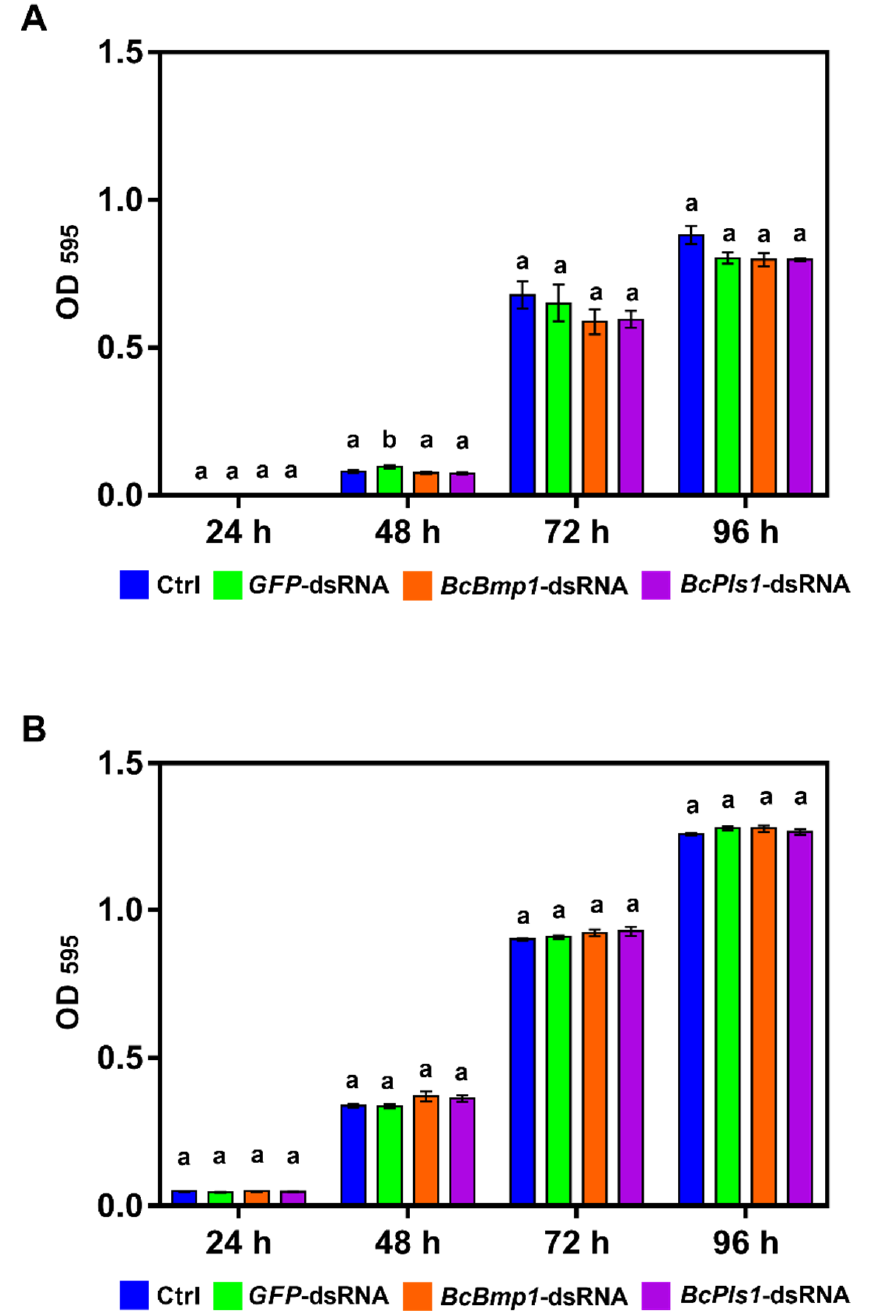
Figure 7. In vitro effects of BcBmp1 -dsRNA and BcPls1 -dsRNA on Trichoderma harzianum T6776 ( A ) and Fusarium oxysporum DAFE SP21-23 ( B ) growth. Fungal growth was assessed by measuring the optical density (OD) at 595 nm at 24, 48, 72, and 96 h in 96-well microtiter plates. In each well, there were aliquots of a conidial suspension of T. harzianum T6776 and F. oxysporum DAFE SP21-23 (5 × 10 2 spores) in SMB medium and 2 µ g of dsRNA ( GFP -dsRNA (green) or BcBmp1 -dsRNA (orange)) or BcPls1 -dsRNA (purple). SMB + TE buffer was used as control (Ctrl, blue). The graphs show the mean ( ± SE) values of eight biological replicates ( n = 8). Same letters above the bars indicate no significant differences from each other (ANOVA) according to Tukey’s HSD test ( p ≤ 0.05). The statistical analysis was conducted separately for 24, 48, 72, and 96 h.